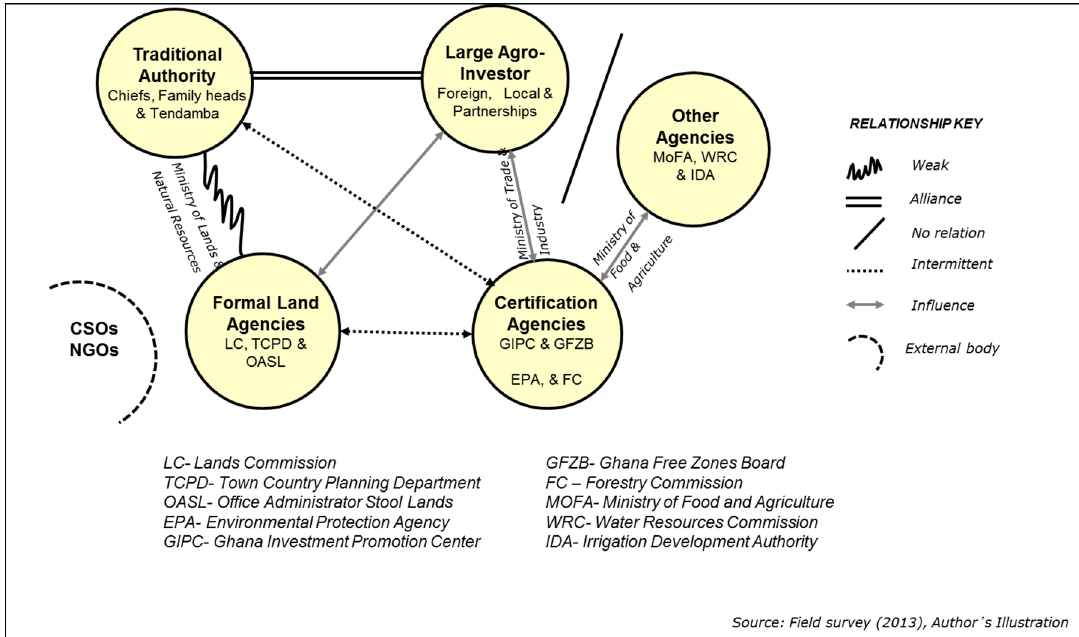
Figure 3. Current stakeholder relationships in formalising large agro-investments. Source: Author’s